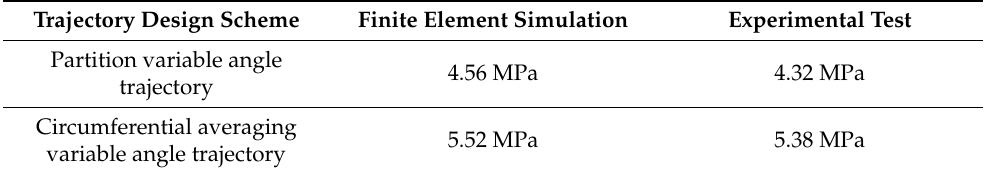
Figure 18. Mechanical properties test on the conical shell surface. Table 4. Results of both experimental testing and numerical